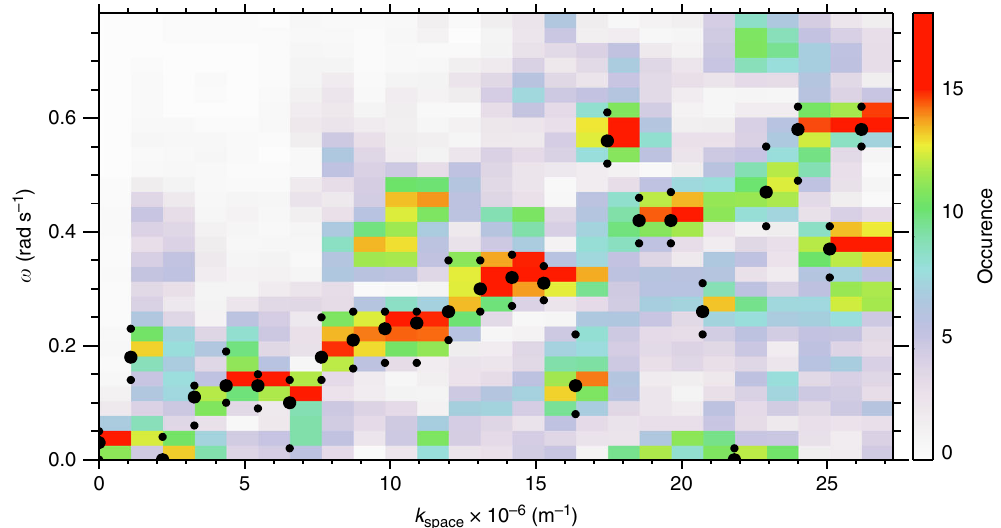
Fig. 7 Observational dispersion relation. The peak occurrences (big dots) and the Full-Width Half Maximum (small dots) are indicated for each wavenumber. For the majority of spatial scales, the peak occurrences lie along the same line. At some spatial scales, multiple peaks make up the distribution in omega. Only the highest peaks in the distribution are shown by the